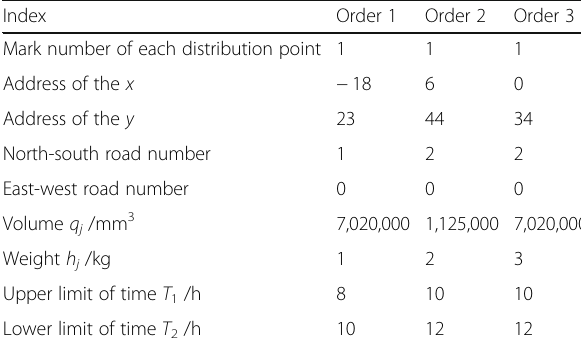
Table 3 Information on delivery of cargo (part) (scale